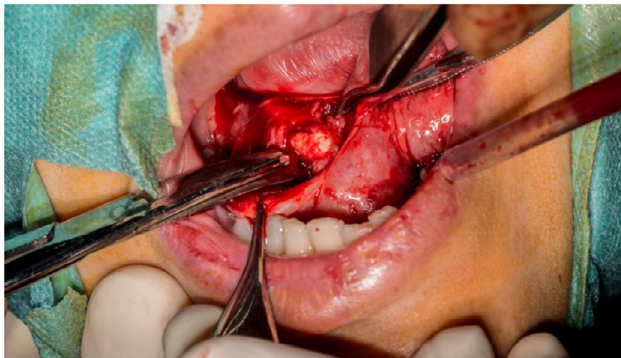
Fig. 13. Clinical view of an incised Wharton ’ s duct showing a salivary stone.